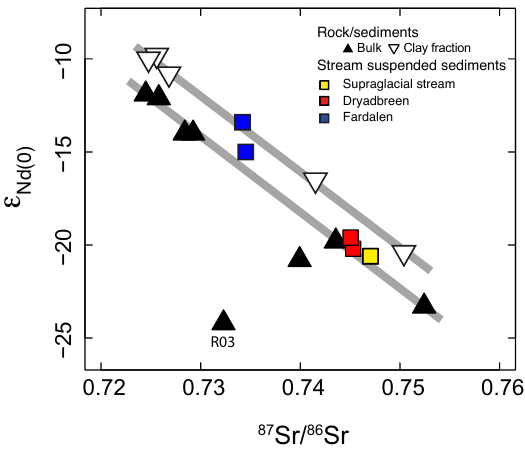
Figure 4. Herron classification (Herron, 1988) of the sedimentary rock samples collected in this study and from the core analysed by Schlegel et al. (2013). Samples G and R01 were collected in the unglaciated catchment (Fardalen) directly from the Frysjaod- den Formation. Samples R03, R02 and R04 were collected in the glaciated catchment (Dryadbreen) but could not be linked to a specific formation in the field due to the heterogeneous nature of moraine material. Based on this classification and the major ele- ment chemistry (Fig. 3) we infer that R03 was derived from the As- pelintoppen Formation and R02 close to the Battfjellet/Frysjaodden boundary. Sample R04 is classified as a shale but has a markedly different iron content (Fig. 3) to the shale samples from the Frys- jaodden Formation (R01, G). Based on its sampled location on the surface of the glacier we infer that it is a shale from either the Bat- tfjellet or Aspelintoppen formations (Fig. 2c).